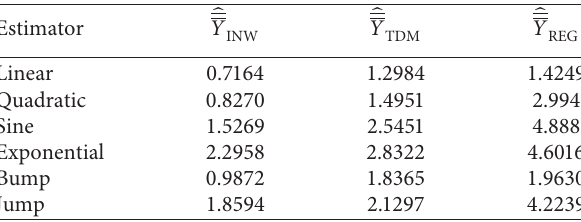
Table 4: Summary results of 95% CI